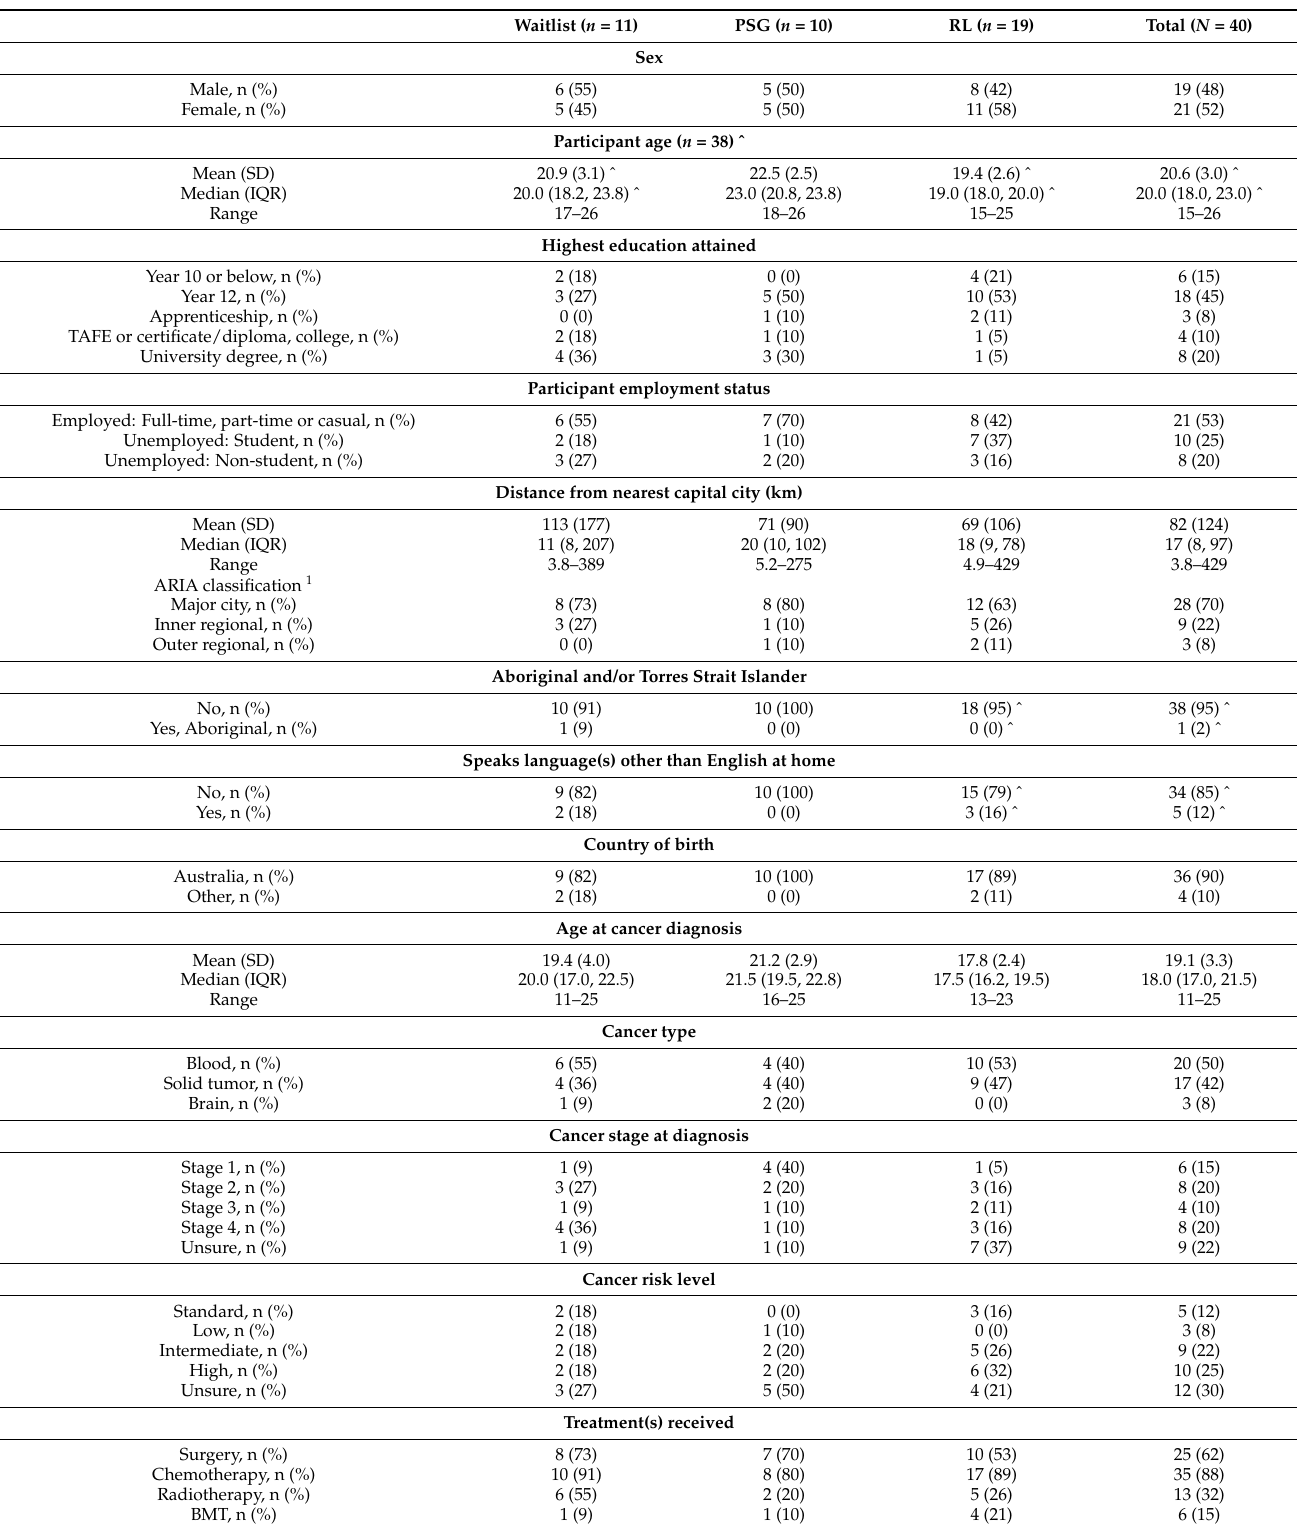
Table 3. Participant demographics by trial